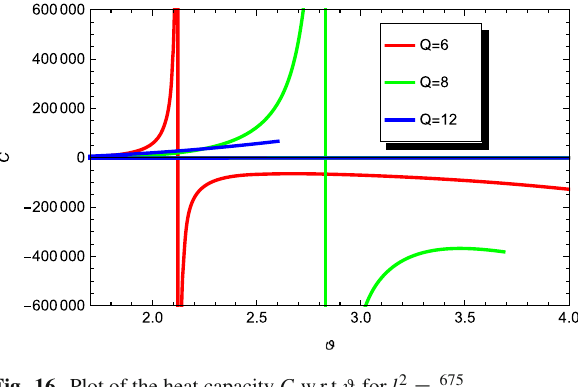
Fig. 16 Plot of the heat capacity C w.r.t ϑ for l 2 = 675